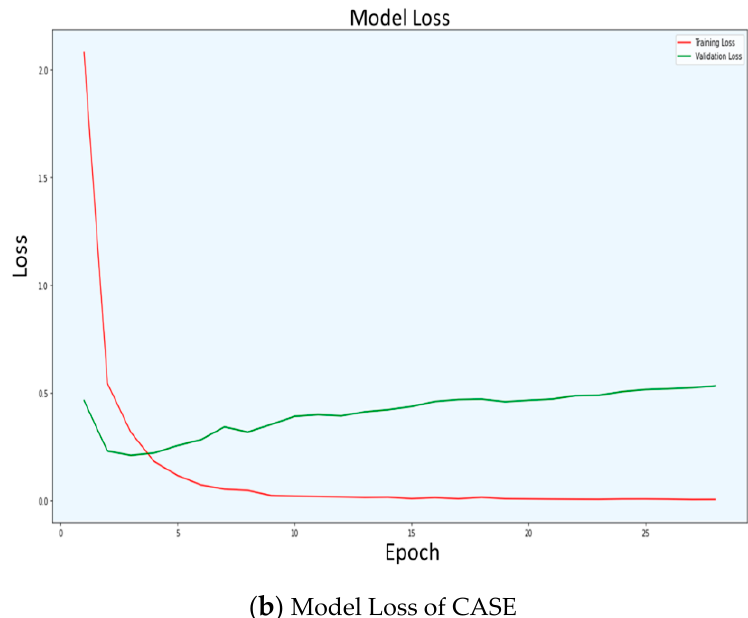
Figure 10. Performance analysis of the deep learning model CASE.